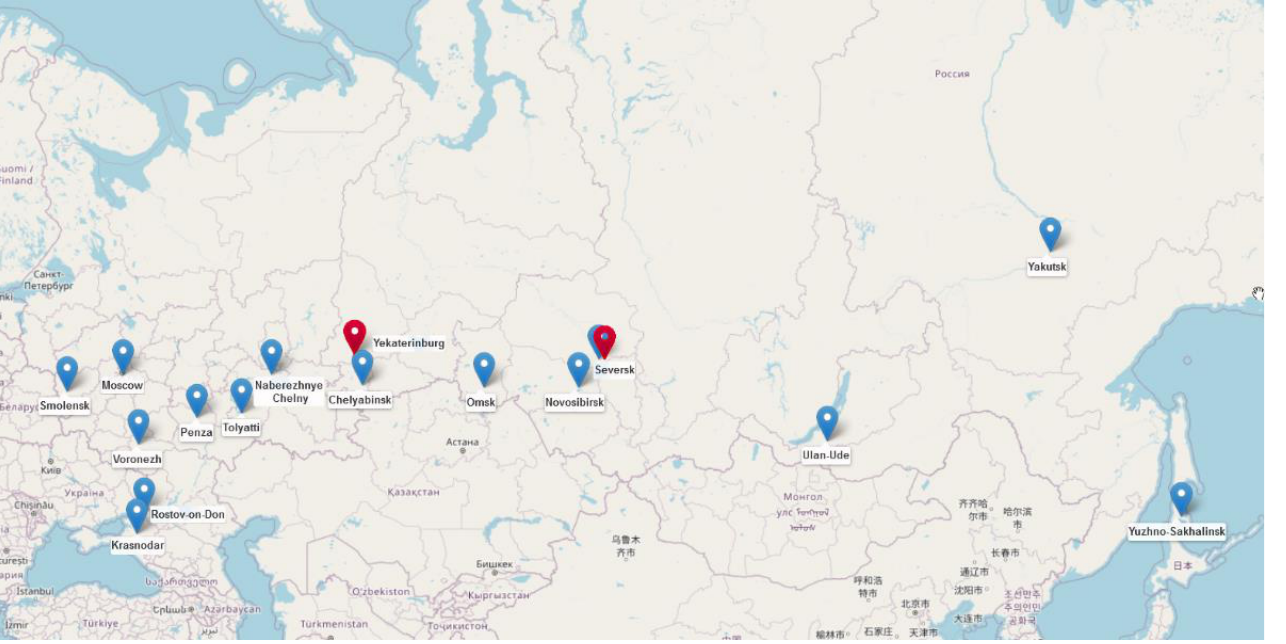
Figure 1. Map showing the geographic origins of mcr -positive E. coli (blue markers) and K. pneumoniae (red markers) isolates from this study.